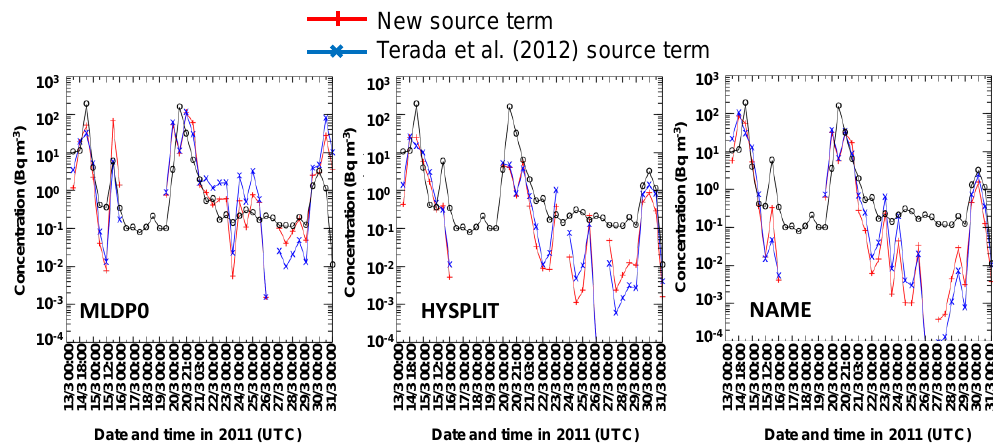
Figure 17. Temporal changes in observed (lines with open circles) and modeled air concentrations (Bqm − 3 ) using three WMO models (MLDP0, HYSPLIT, and NAME) with the source terms of this study (red lines with pluses) and Terada et al. (2012) (blue lines with crosses) for 137 Cs at JAEA-Tokai in Ibaraki Prefecture from 13 to 31 March 2011.